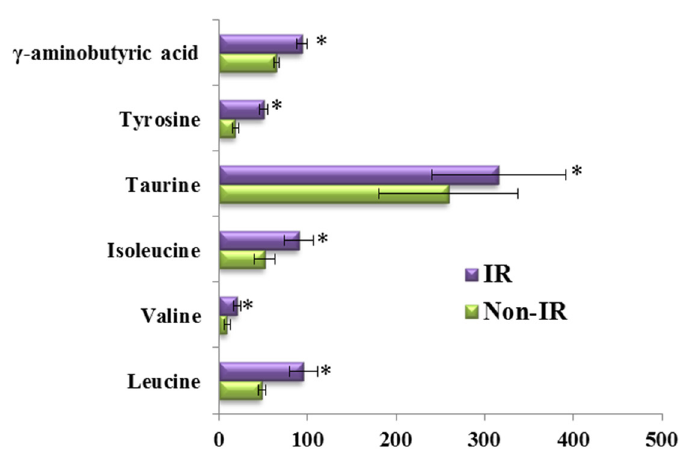
Figure 5. Percent changes of metabolites from fasting to 2 ‐ h samples during an OGTT between female ( A ) and male ( B ) in the control (Orange) and HLP groups (Purple). Percent changes for the metabolites (X) detected by UPLC ‐ TQ ‐ MS were calculated as follows: X Percent change = (X Concentration at different time (120) − X Concentration at baseline )/(X Concentration at baseline ). * p < 0.05, ** p < 0.01, compared with the control group using student’s t test.